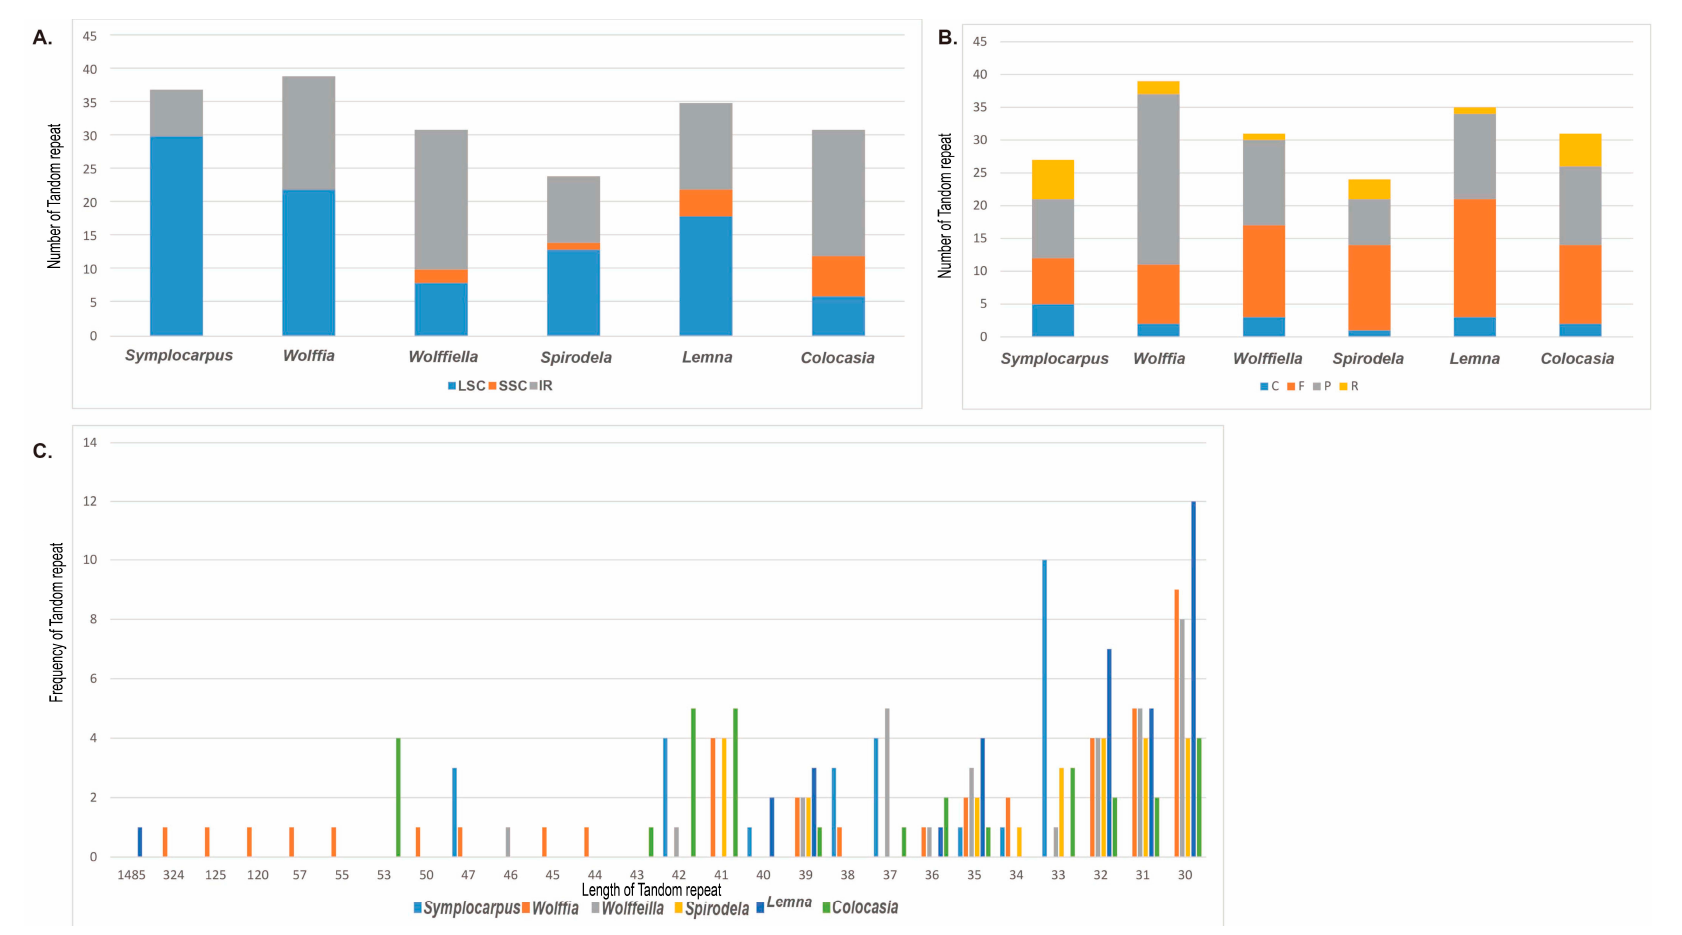
Figure 4. Analyses of tandem repeated sequences in the Araceae chloroplast genome. ( A ) Distribution of tandem repeats in Araceae species. F, P, R and C indicate the repeats matching in forward, palindrome, reverse and complement orientation, respectively ( B ) Type of tandem repeats in Araceae species. ( C ) Frequency of tandem repeats sequences in Araceae species.